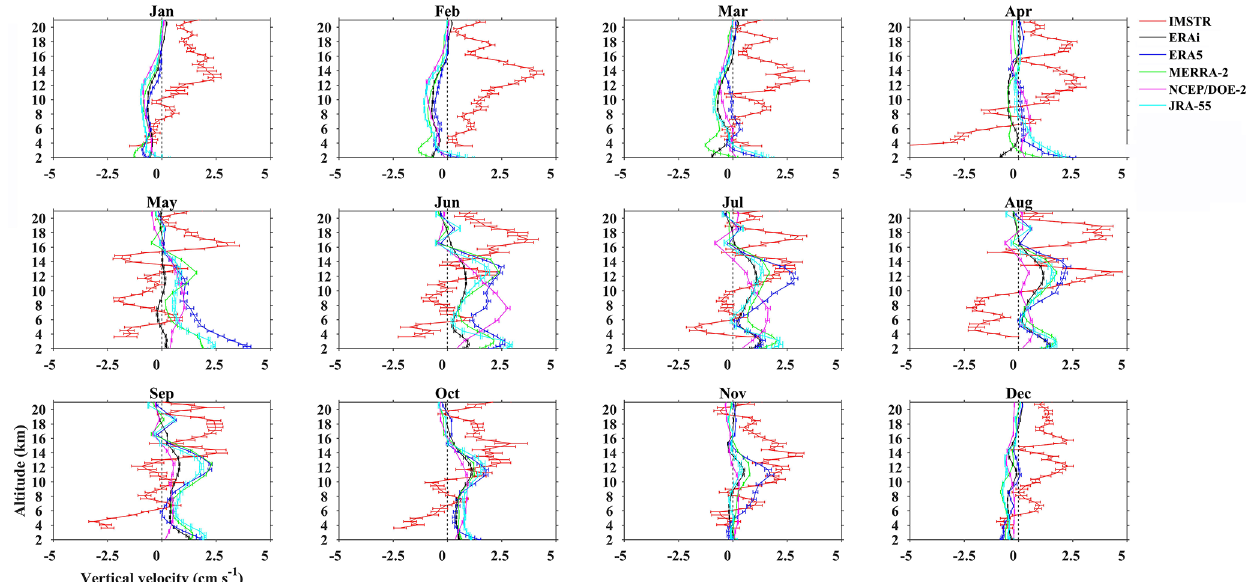
Figure 4. Climatological monthly mean altitude profile of w obtained from IMSTR and five reanalyses over Gadanki from 1995–2015. Horizontal lines indicate the standard error.